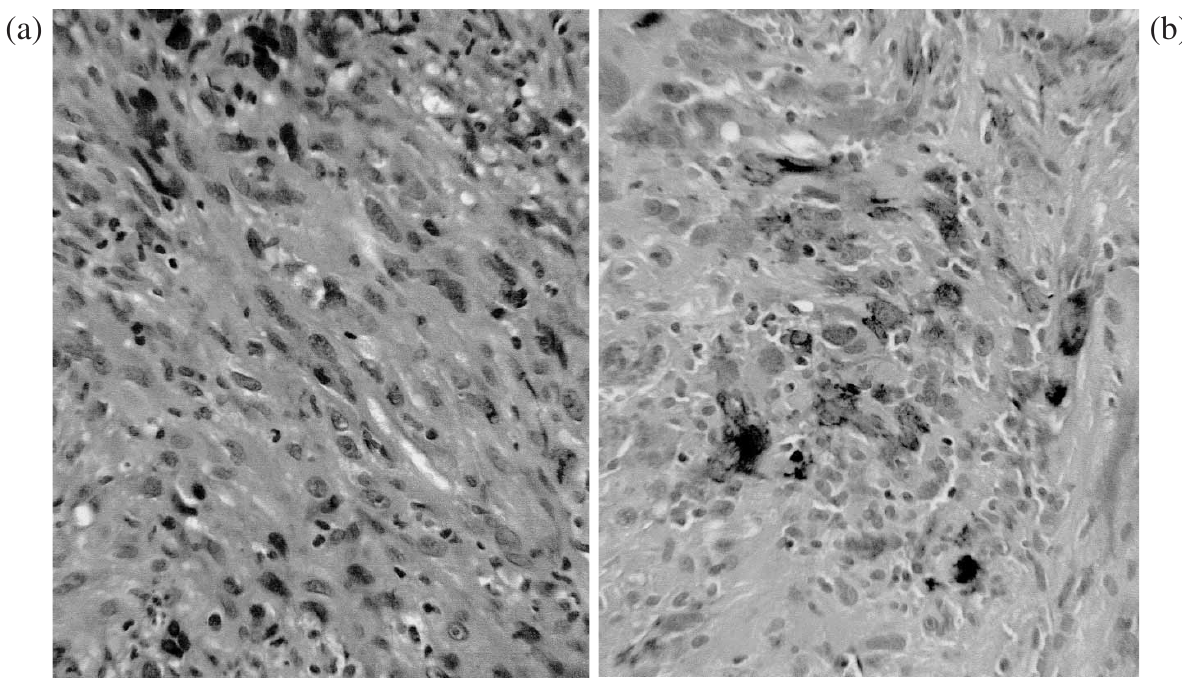
Fig. 2. (a) High power H&E stain reveals a pleomorphic high-grade spindle cell neoplasm. (b) Representative high power view of immunostain for SMA. SMA, as well as muscle specific antigen, is clearly positive in pleomorphic malignant tumor cells. Desmin and Leukocyte common antigen were negative, and S100 and keratin showed occasional positivity. (LMS may occasionally show keratin